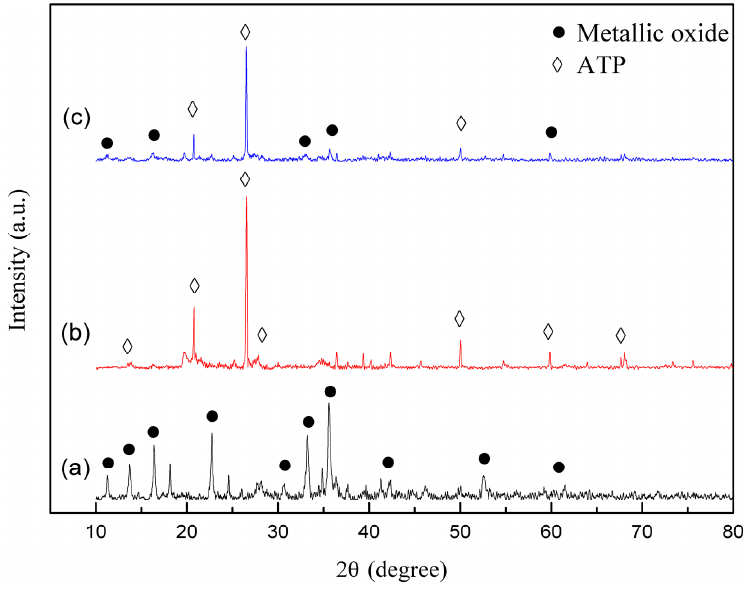
Figure 1. X-ray diffraction ( XRD) patterns of ( a ) Fe-Mn-Cu, ( b ) ATP and ( c ) Fe-Mn-Cu@ATP. As revealed in Figure 2, the morphologies of the original ATP, modified ATP, Fe-Mn-Cu and Fe-Mn-Cu@ATP catalysts were characterized by